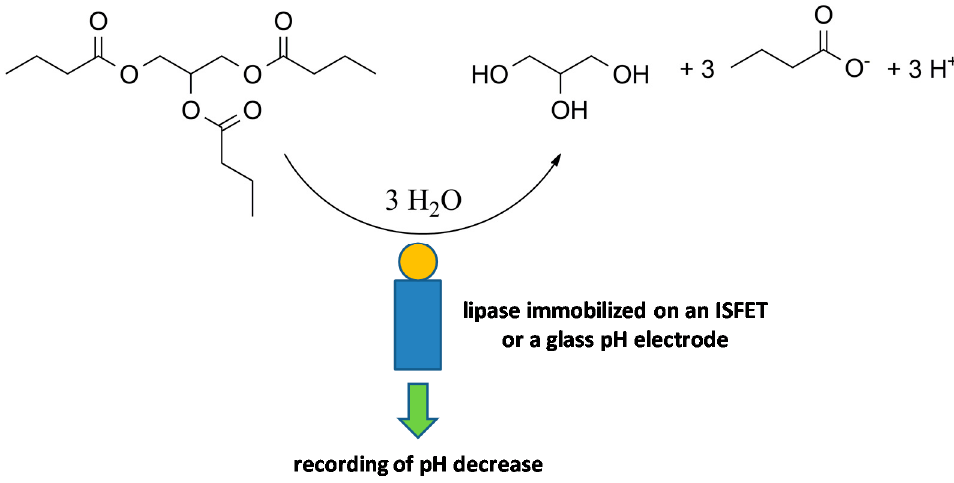
Figure 4. The general principle of a triglyceride assay such as a tributyrin (in the figure) assay by a lipase biosensor recording the change in pH. The tributyrin is hydrolyzed up to glycerol and the butyric acid has an impact on the pH of the solution.